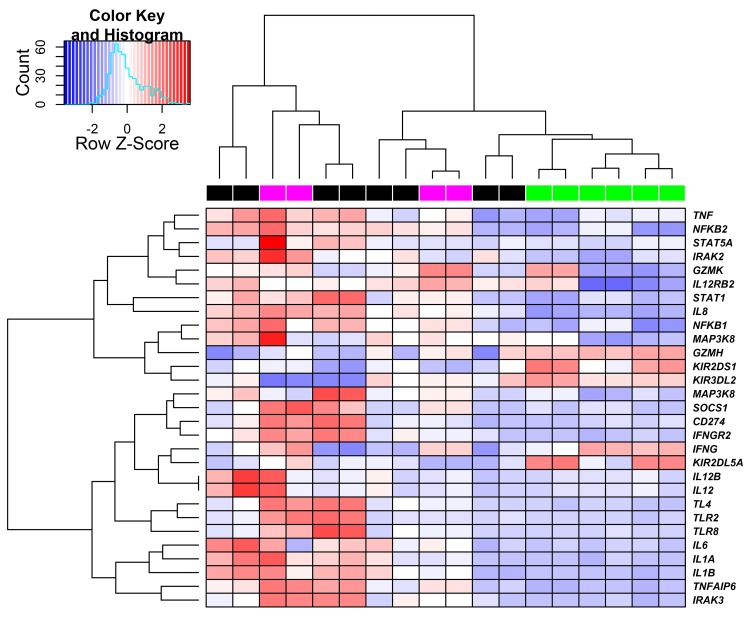
Gene expression profiles through an unsupervised hierarchical clustering approach of differentially expressed genes in both, non-stimulated and LPG-stimulated NK cells.The heatmap shows expression patterns of genes involved in the activation of the immune response. Columns represent samples, color bars on the horizontal above the heatmap label the different groups: DCL in green, LCL in magenta and Controls in black. Each row represents gene expression level across samples. Heatmap colors show up-regulation in red and down-regulated genes in blue.